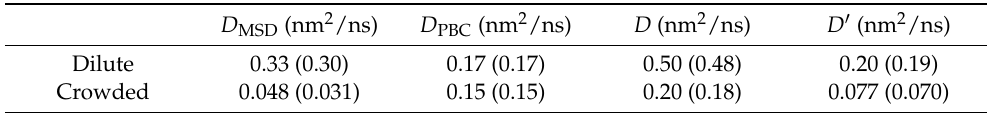
Table 1. Diffusion coefficients of villin in the dilute and crowder solutions with NBFIX 1.03 scaling factor. The values for 1.00 scaling are shown in